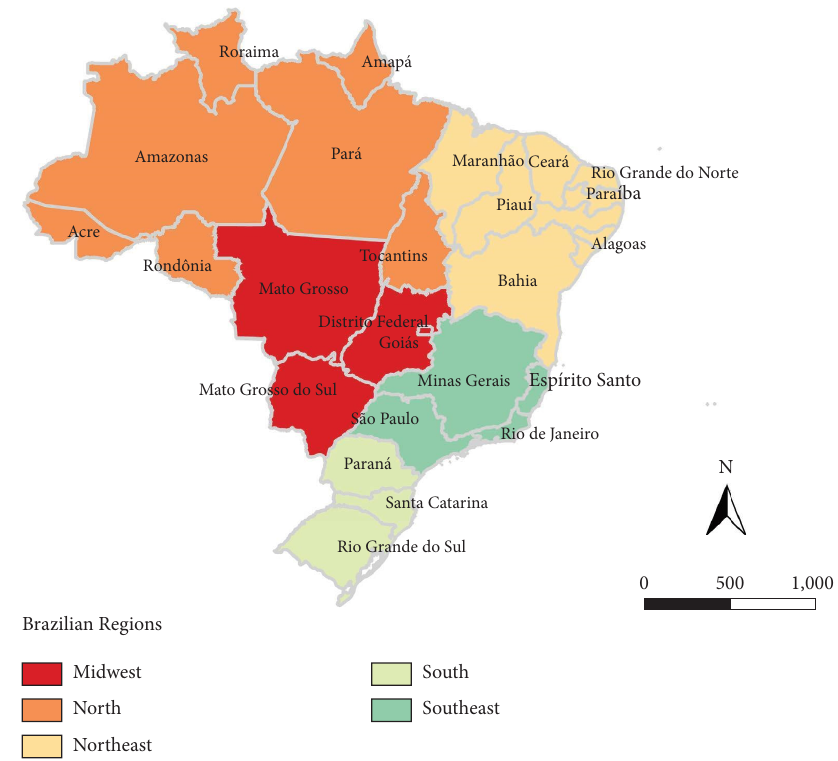
Figure 1: Brazilian regions and states. Source: IBGE